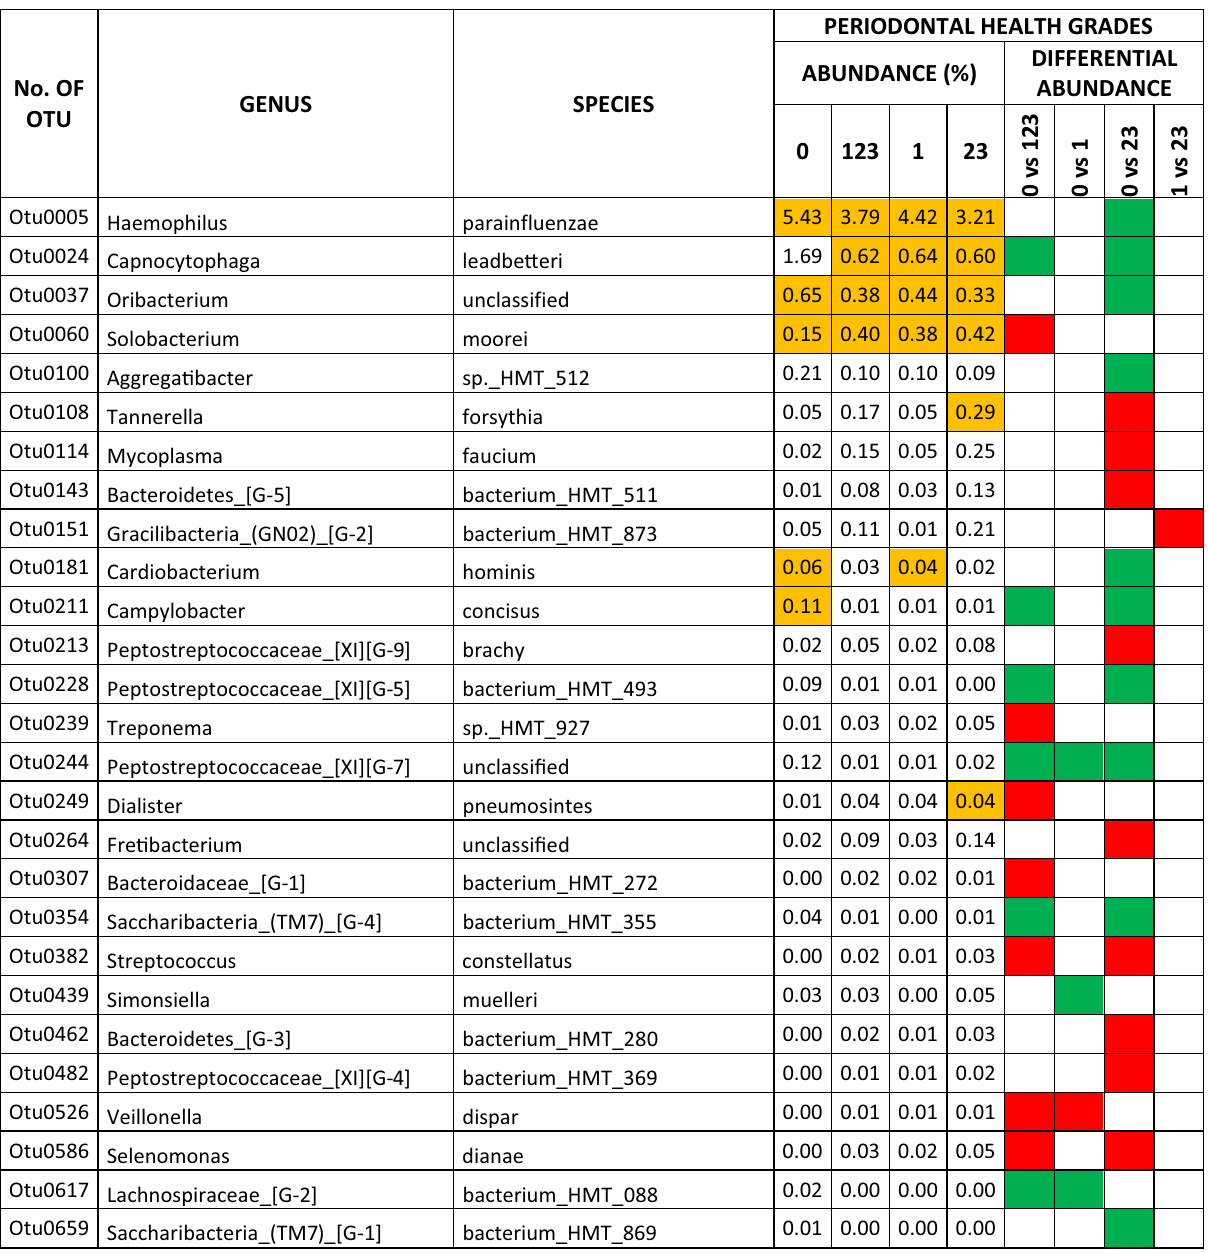
respectively. The contribution of each OTU (value of the coefficient of the variable) that was included in the predictive models of the different clinical conditions is detailed in the supplementary data S5.